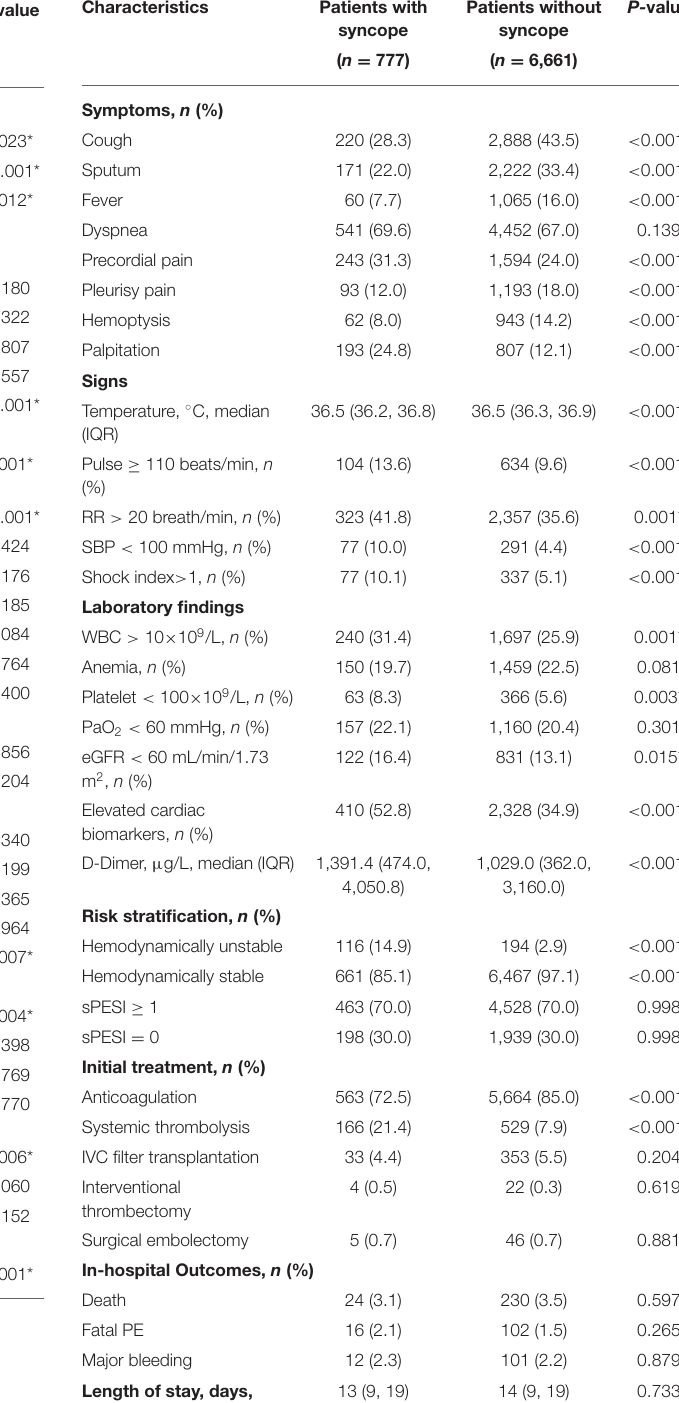
There were significantly fewer patients with heart failure, chronic obstructive pulmonary disease and pulmonary infection